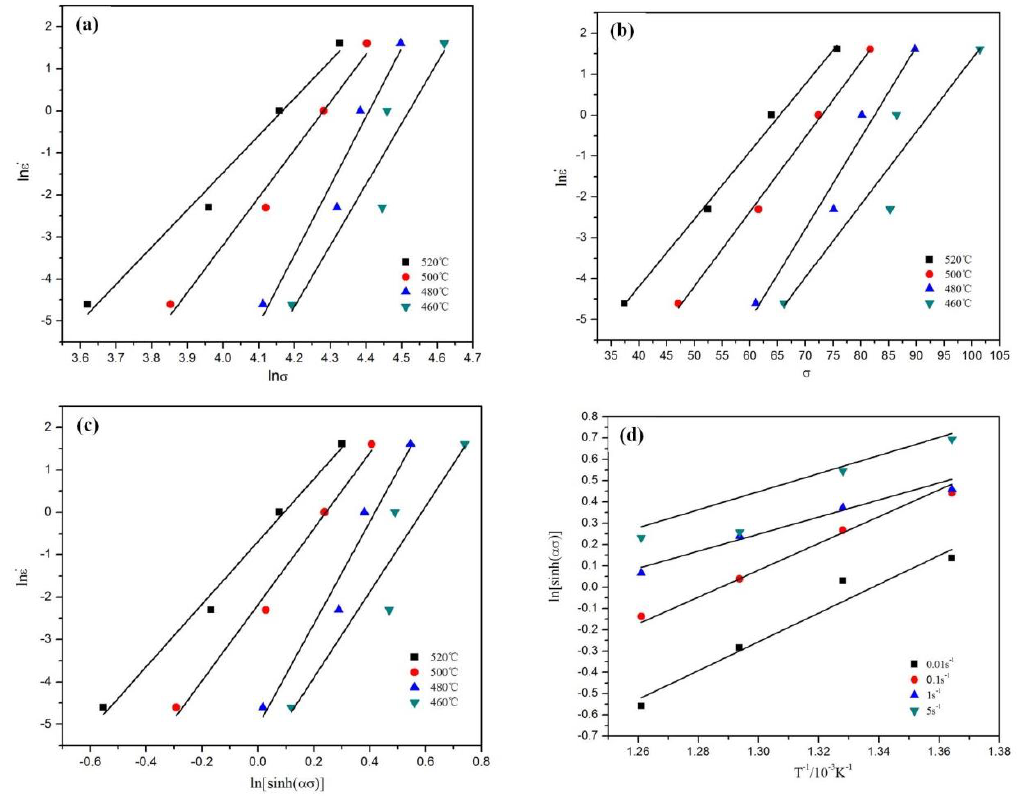
. ε . ε –ln σ , ( b ) ln – σ , ( c )